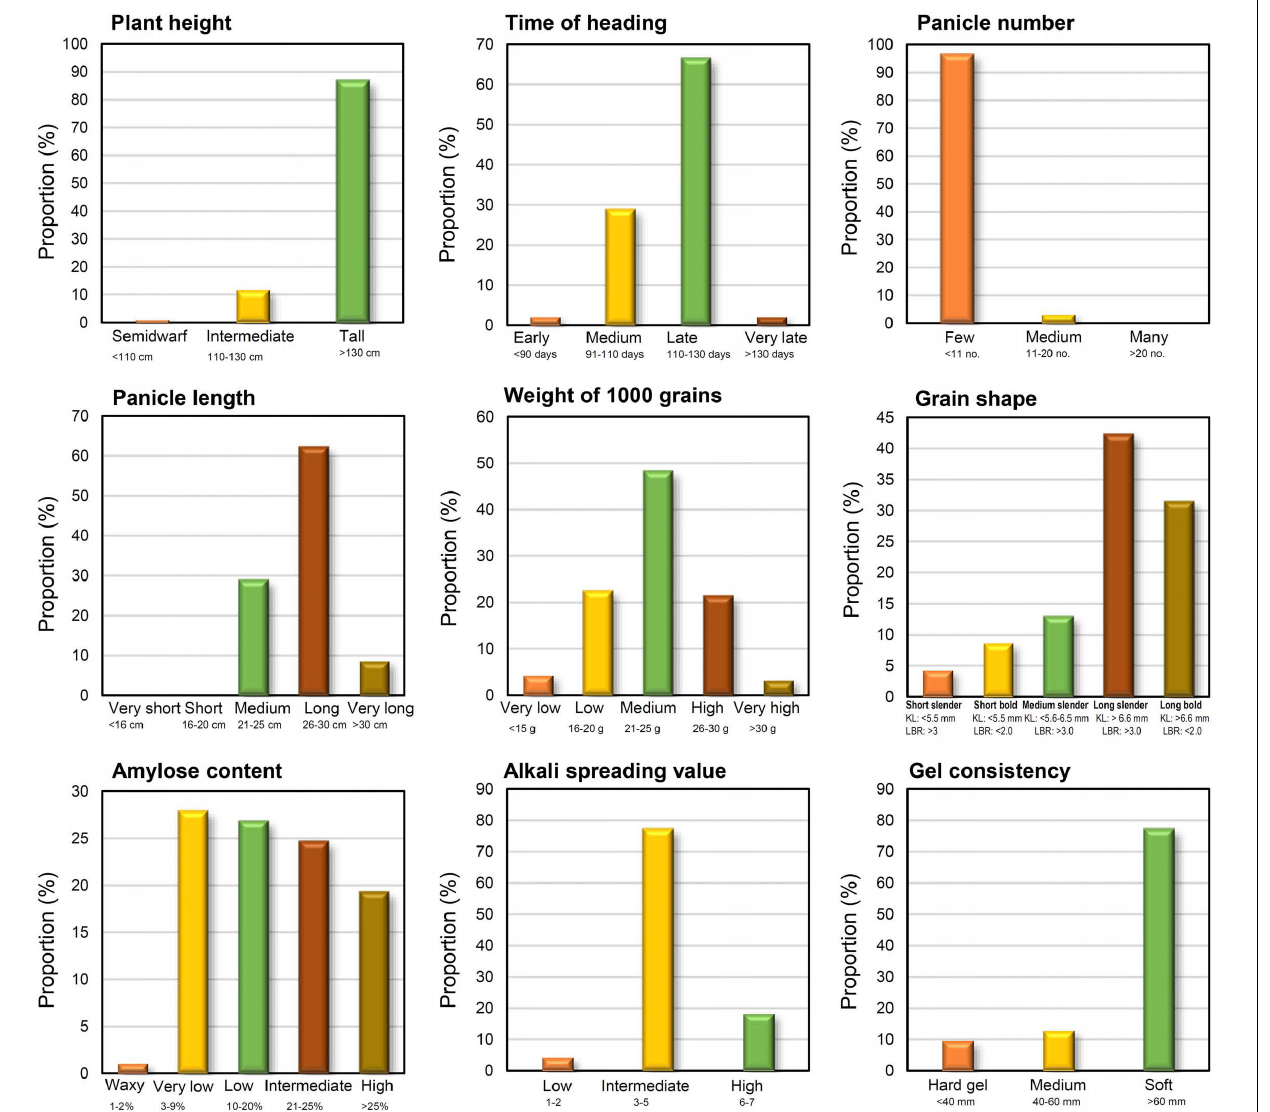
FIGURE 2 | Distribution of aromatic rice genotypes of Manipur, based on agro-morphology and grain quality by standard evaluation system (SES)